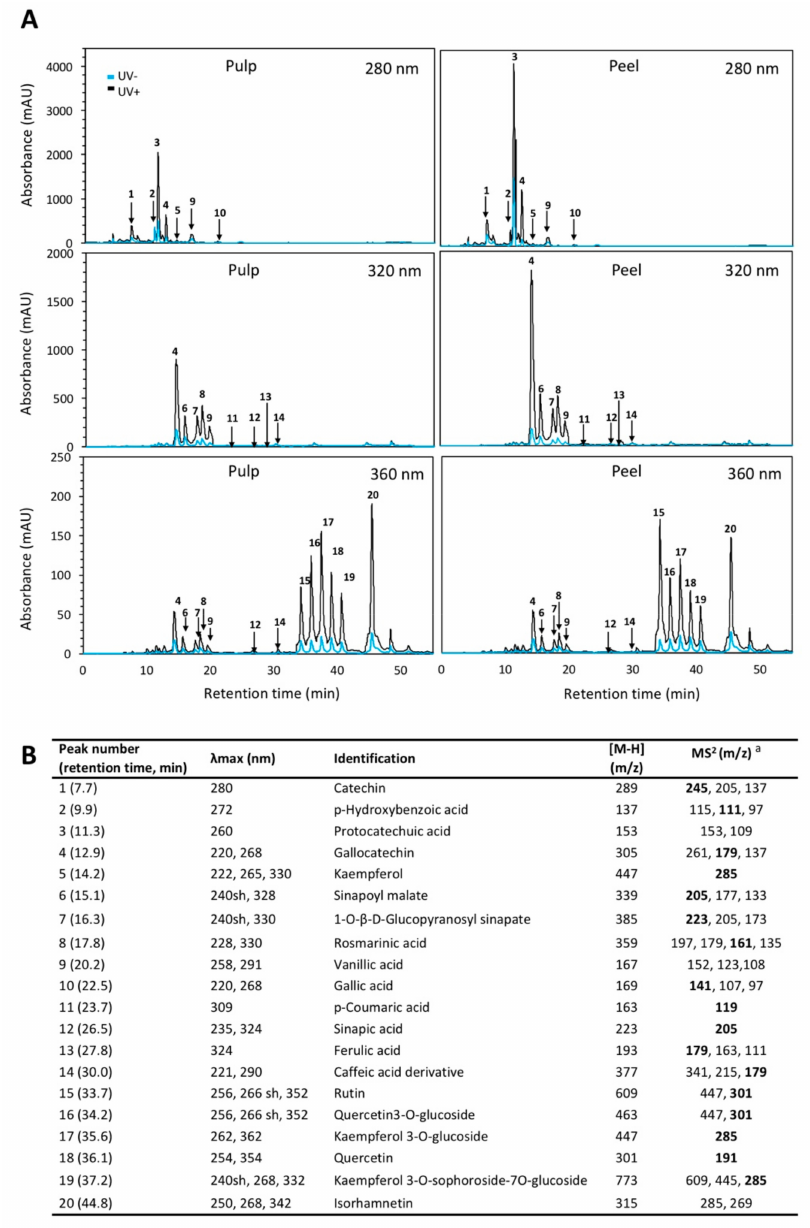
Figure 1. ( A ) Typical HPLC-diode array detector (DAD) chromatogram, shown at 280, 320, and 360 nm of identified phenolic compounds from methanol / water (50:50, v / v ) extracts obtained from red prickly pears pulp and peel treated and non-treated with ultraviolet B (UVB) light for 15 min and stored for 24 h at 16 ◦ C. ( B ) Identification of individual phenolic compounds in red prickly pear. Identification was obtained by HPLC-DAD and HPLC-electrospray ionization (ESI)–sequential mass spectrometry (MS n ). Abbreviations: shoulder (sh). a Major fragment ions are highlighted in